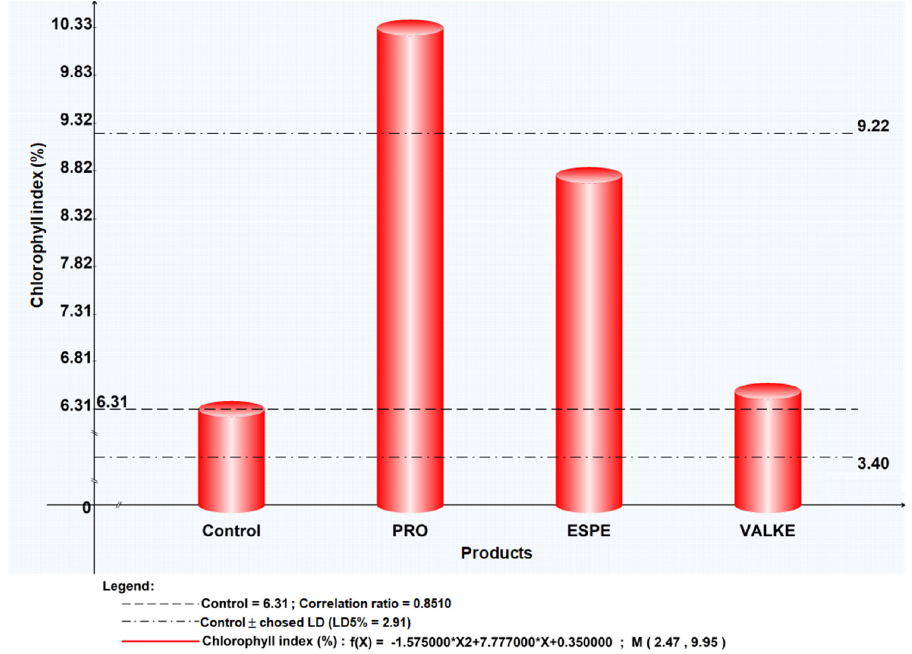
Figure 8. Chlorophyll index for maize plants treated with keratin hydrolysates.